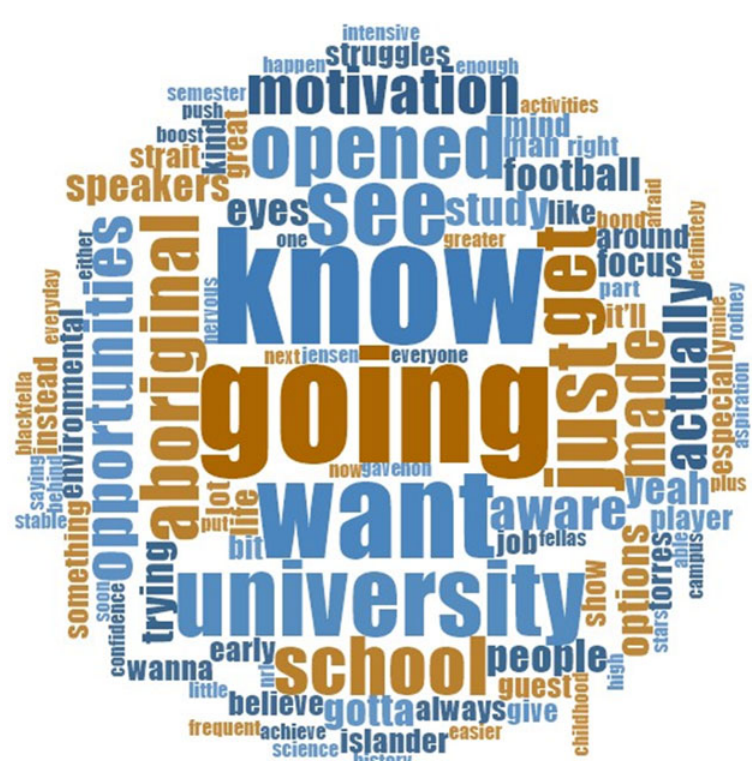
Fig. 3. Tag cloud of participants ’ perceptions of the impact of Burunga M Gambay on motivating them to engage in education.